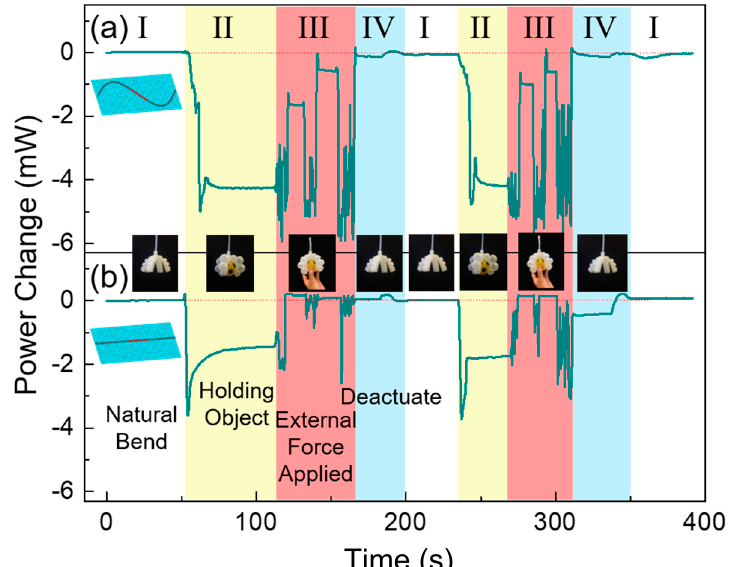
Figure 7. Power change measurement during various motions and events occurring at the soft robotic gripper: ( a ) with sinusoidally configured FBG; and (b ) with straightly configured FBG.